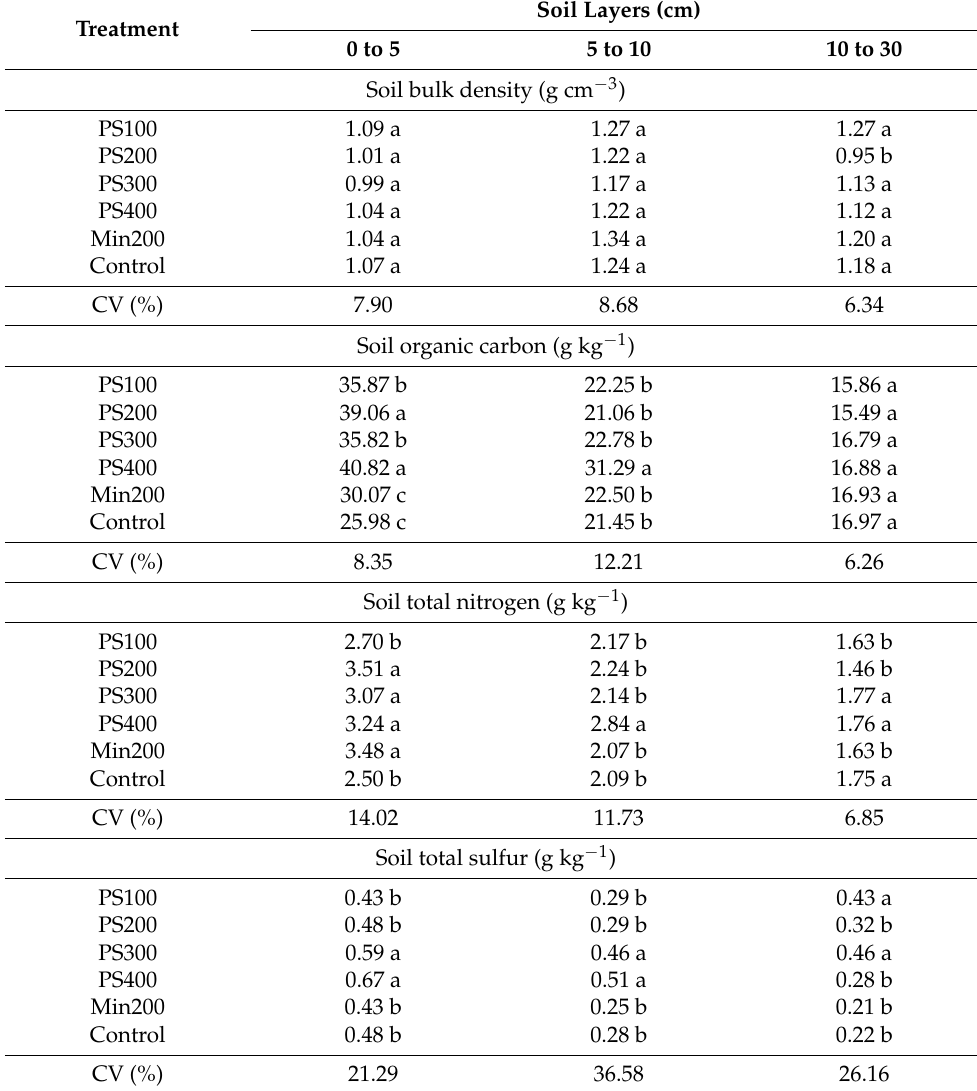
Table 4. Soil bulk density, and carbon, nitrogen, and sulfur contents after application of organic (pig slurry; PS) and mineral (urea; Min200) fertilizers. Ibirub á , Rio Grande do Sul, Brazil. Soil Layers Treatment